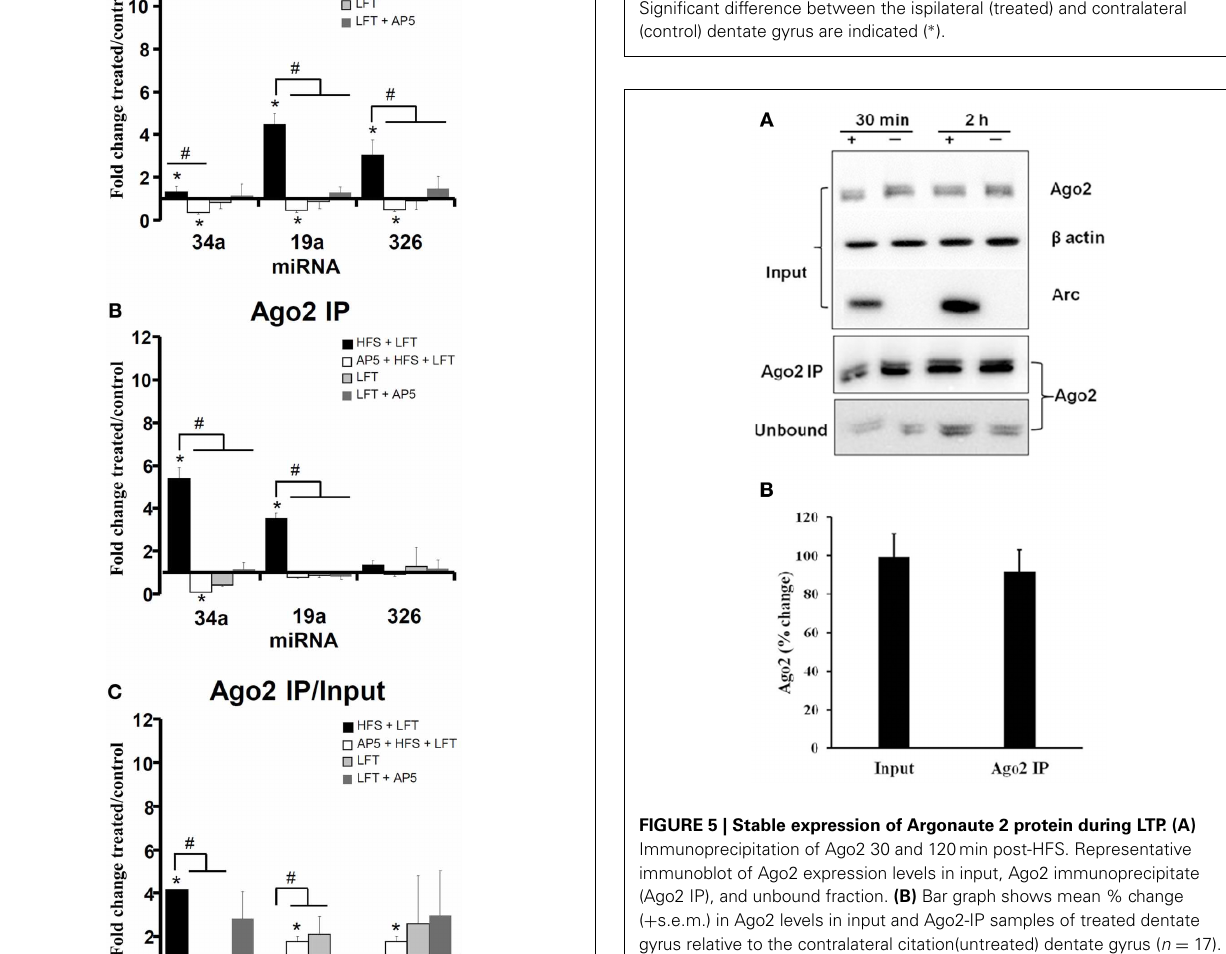
( Table 1 ) including MAPK, mTOR, and Ras signaling